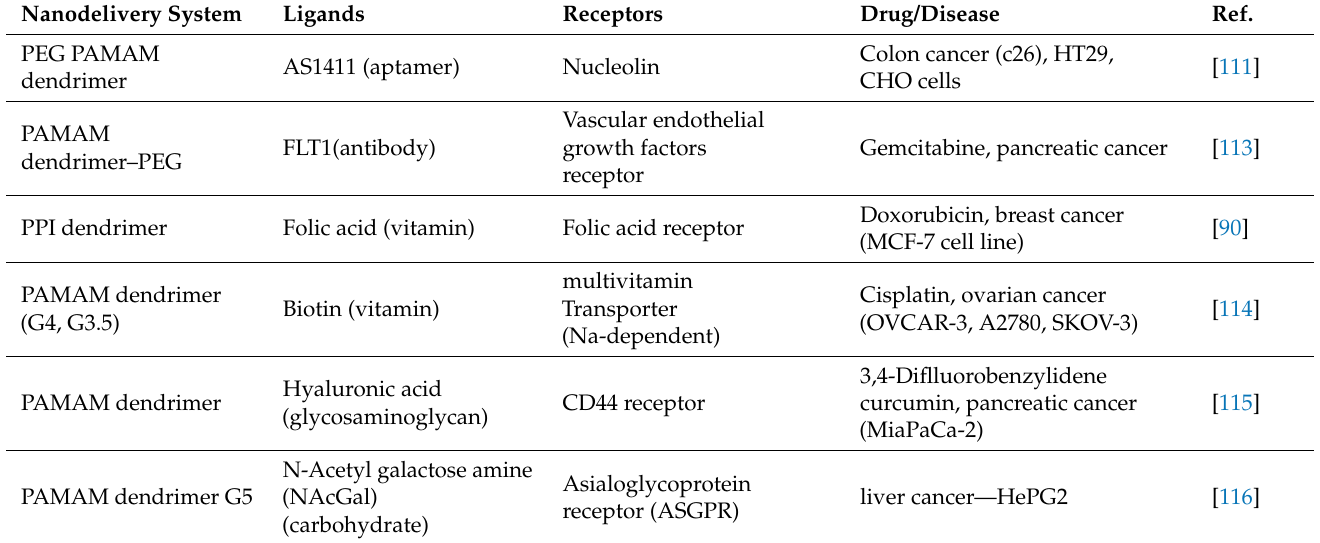
Table 2. Targeting ligand-functionalized dendrimers